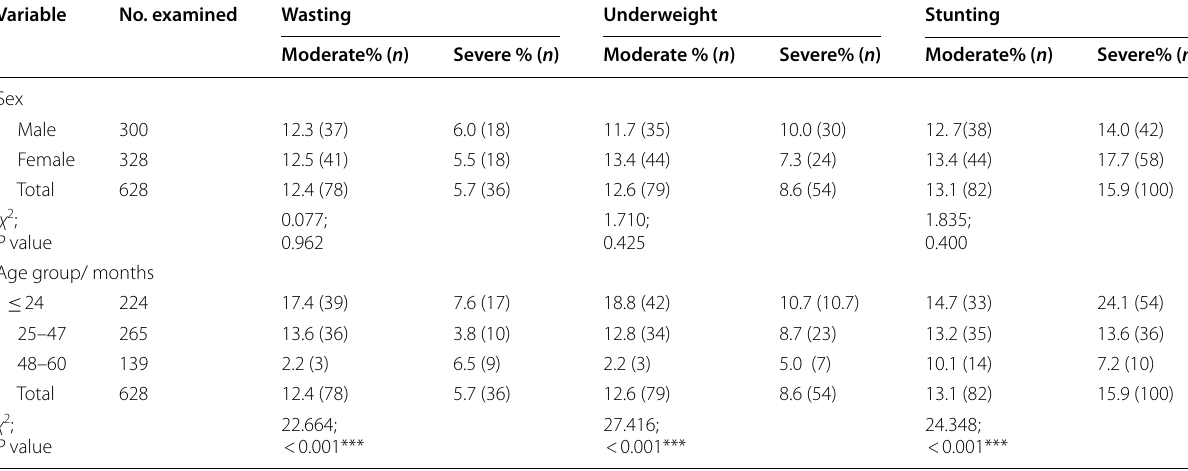
***Statistically significant at P <